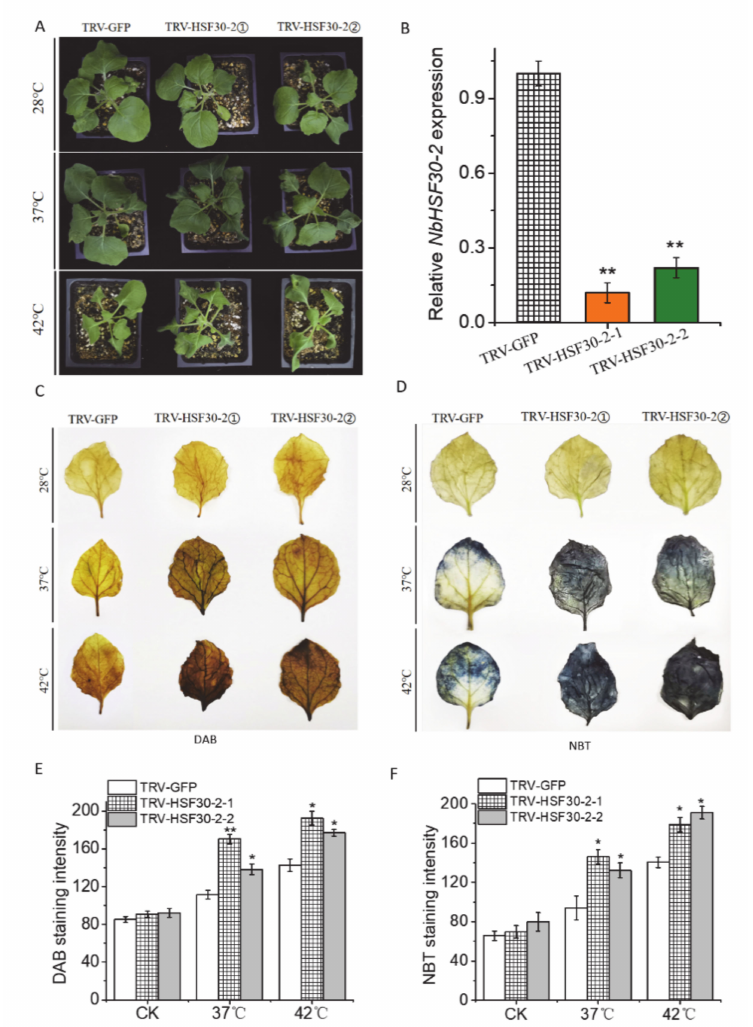
Figure 4. Phenotype of HSF30-2 silencing in tobacco under heat stress. ( A ) Phenotype of HSF30-2 - silencing in tobacco by virus-induced gene silencing (VIGS) before and after heat shock. TRV- HSF30-2 means the silencing of the CvHSF30-2 homologous gene in tobacco. TRV-HSF30-2 1 (cid:13) and TRV-HSF30- 2 2 (cid:13) represent two different HSF30-2 -silencing lines. ( B ) Silencing effect of TRV- HSF30-2 plants based on qPCR. ( C , D ) DAB and NBT staining of HSF30-2 -silenced tobacco after heat treatment. ( E , F ) DAB and NBT staining quantified using the ImageJ2x program. The unit on the x-axis is the average grey value. The staining intensity was quantified using the ImageJ2x program. The image (inverse phase) was changed into an 8-bit grey image, and the average grey values from the upper, middle and lower areas of root tips calculated by ImageJ2x reflect the staining intensity. Error bars represent the standard error of three biological replicates. * p < 0.05; ** p < 0.01. TRV: tobacco rattle virus; CK: control check (normal